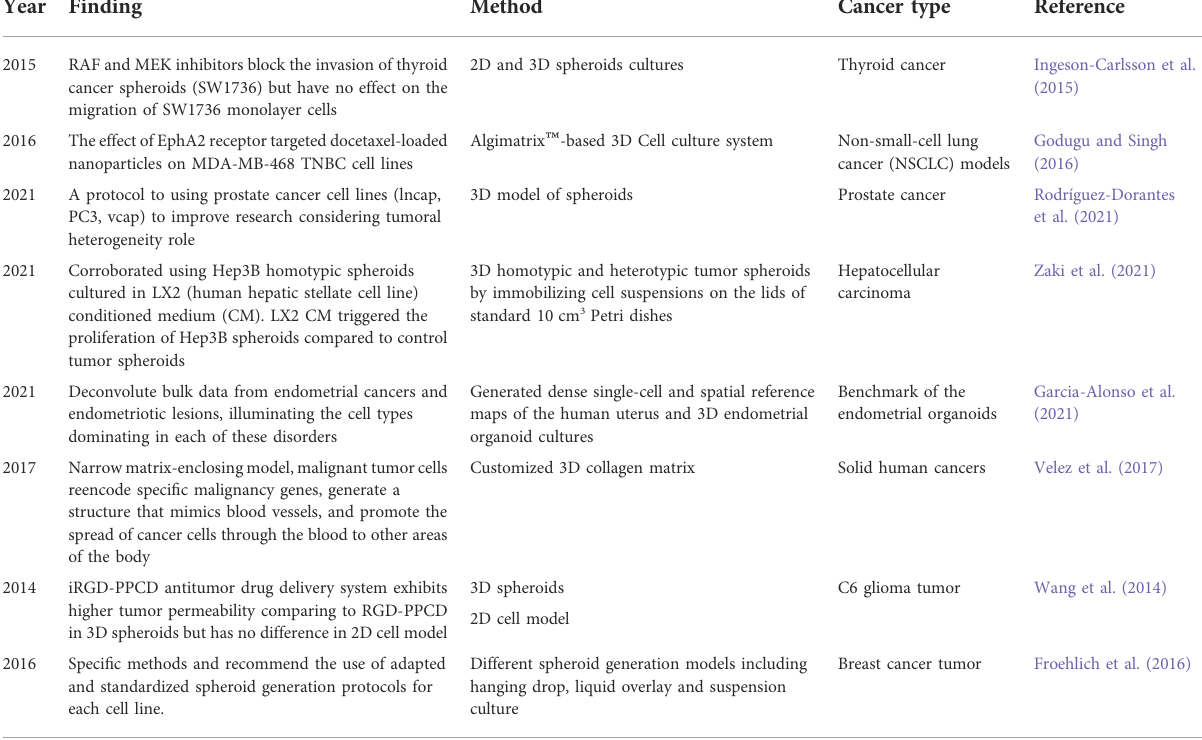
TABLE 1 Various applications of 3D tumor organoid models in drug screening and